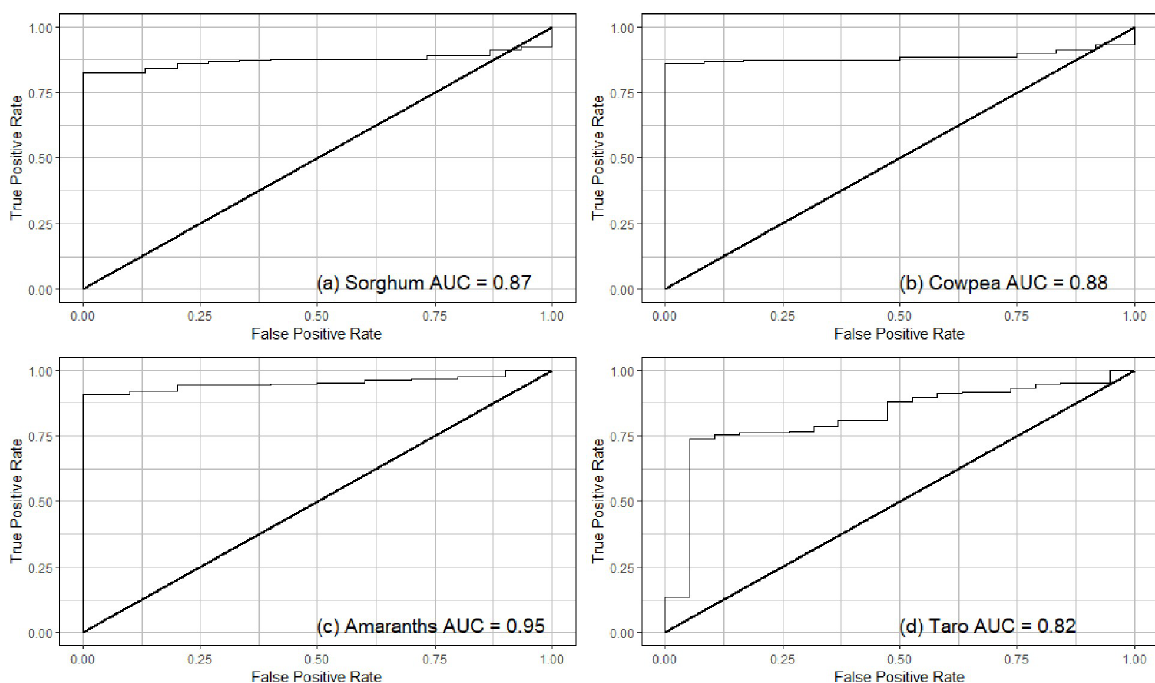
Fig 7. The Receiver Operating Characteristic (ROC), used to generate the Area Under the curve (AUC) which is used for model validation of the logistic regression model for spatial prediction of (a) sorghum, (b) cowpea, (c) amaranth and (d) taro.